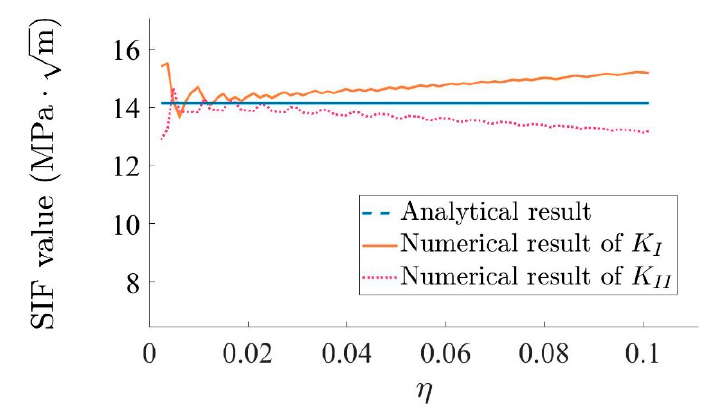
Figure 19. Comparison between numerical and analytical results for K I and K II